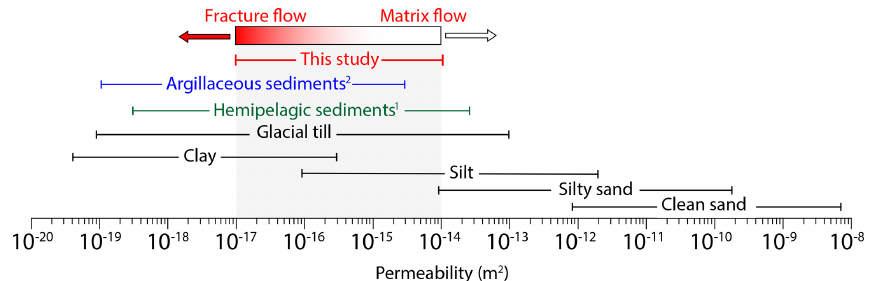
Figure 3. Typical range of permeability for unconsolidated sediments and marine sediments. Data sources are as follows: black – Freeze and Cherry (1979); green – Spinelli et al. (2004), porosity–permeability marine data compilation for porosities between 40% and 85%; blue – Neuzil (1994). Data from Neuzil (1994) are a compilation of laboratory permeability data for natural clay, silt sand mixtures from marine and terrestrial sources with porosities of